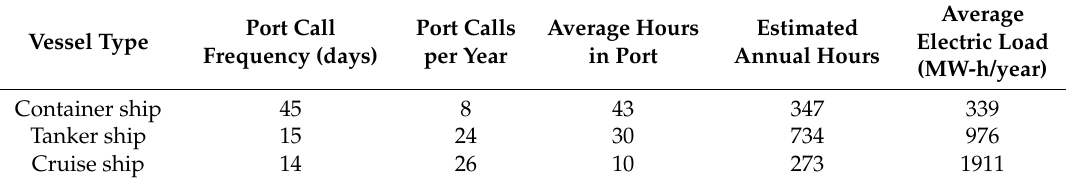
Table 3. Hotel loading of Post Panamax ship at